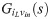
Bode diagrams of GiLvin(s), Gvovin(s), GiL
d(s) and Gvo
d(s) with different α, β and γ: (a) GiLvin(s); (b) Gvovin(s); (c) GiL
d(s); (d) Gvo
d(s).